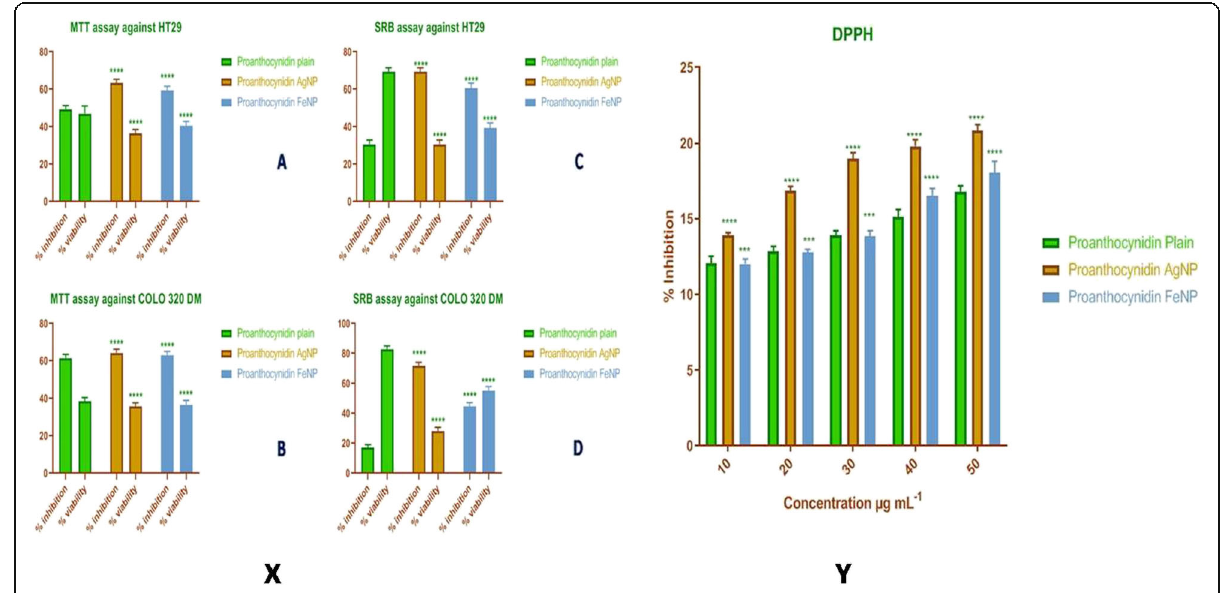
Fig. 4 Graph of x cytotoxicity and y antioxidant DPPH